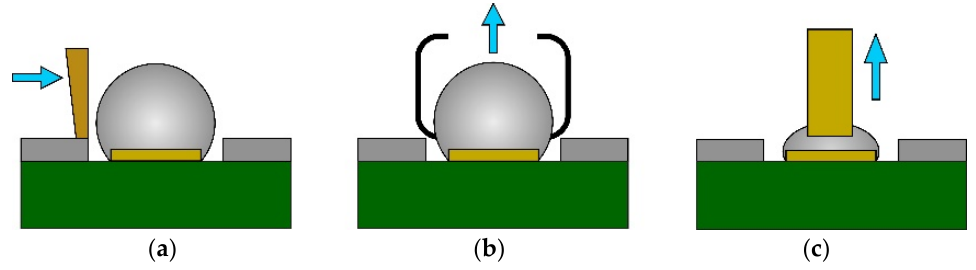
Figure 1. Methods for pad cratering evaluation: ( a ) ball shear; ( b ) ball pull; ( c ) pin pull.